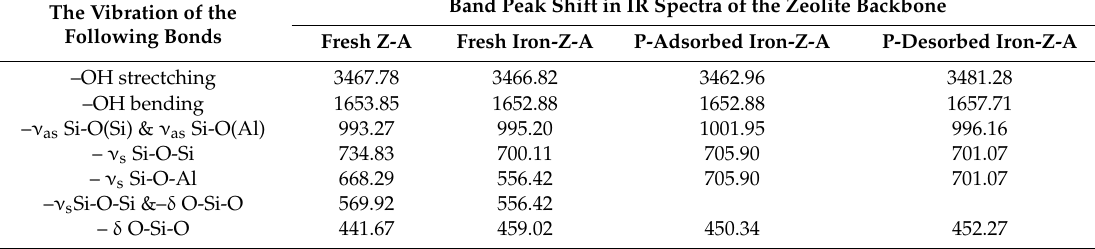
Figure 3. The FT-IR spectrum of different bonds on the fresh Iron-Z-A, P-adsorbed Iron-Z-A, and P- desorbed Iron-Z-A backbone. Table 1. FT-IR bond stretching and vibrations of di ff erent band peak shifts in the IR spectra of the zeolite Table 1. FT-IR bond stretching and vibrations of different band peak shifts in the IR spectra of the zeolite backbone.